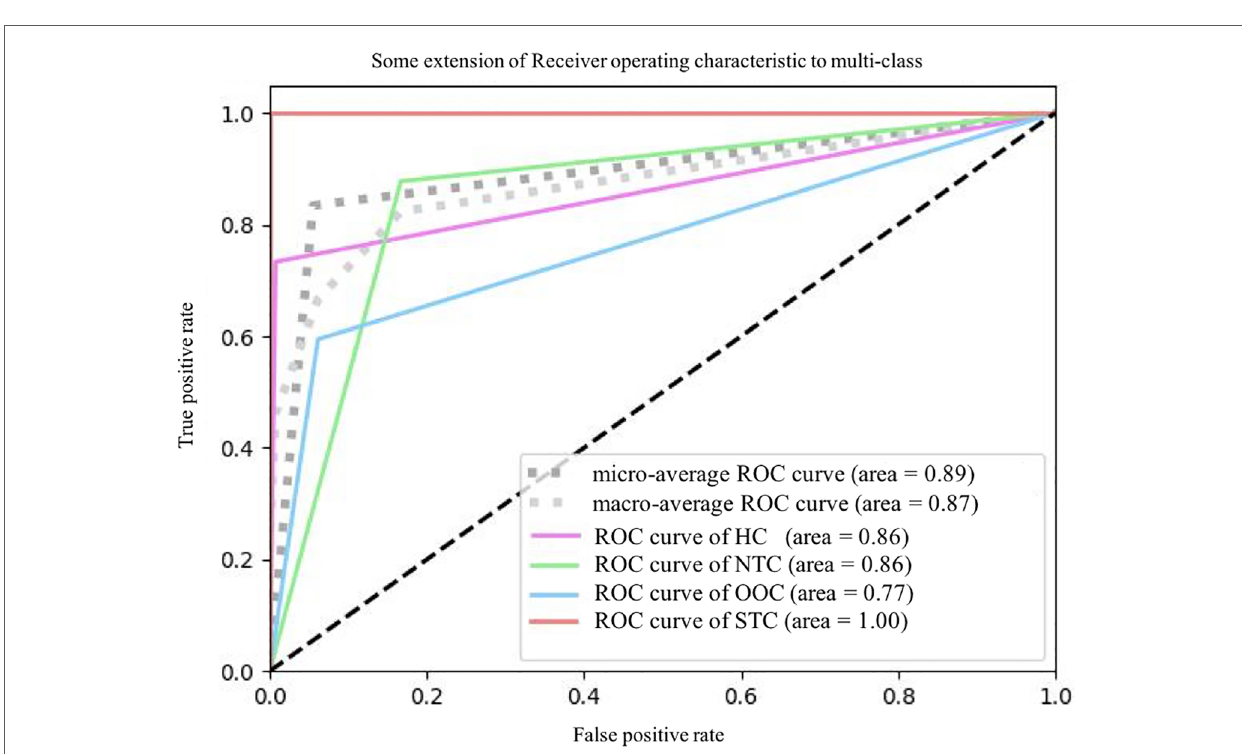
FIGURE 5 The ROC plots of LGBM classi fi cation. ROC, receiver operating characteristic curve; HC, healthy controls; NTC, normal transit constipation; OOC, outlet obstruction constipation; STC, slow transit